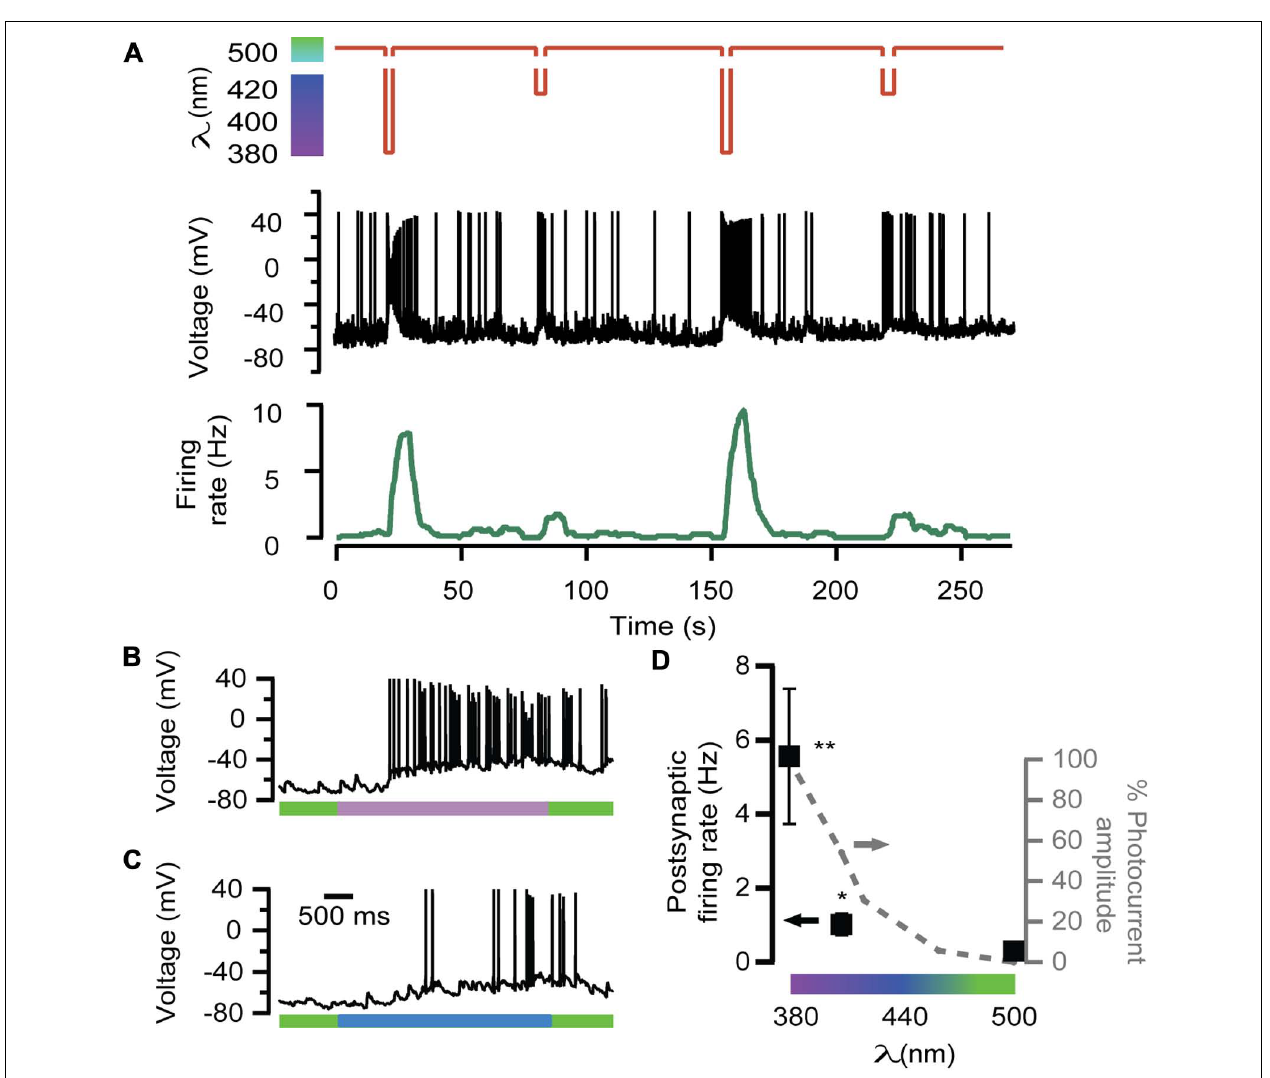
firing rate from postsynaptic LiGluR( − ) neurons, in response to 380, 408, • , left y -axis, N = 4 cells) and photocurrent and 500 nm light pulses ( amplitude of the presynaptic neuron at the same wavelengths measured in LiGluR( + ) hippocampal neurons by whole-cell voltage-clamp, following the • -, right y -axis, N = 4 cells). same protocol described in Figure 2A (- **Significantly different from 500 nm with p < 0.05; *significantly different from 500 nm with p < 0.1. All pairs were compared using a non-parametric multiple comparison test (Kruskal–Wallis) and a multicompare LSD test. Error bars indicate ±